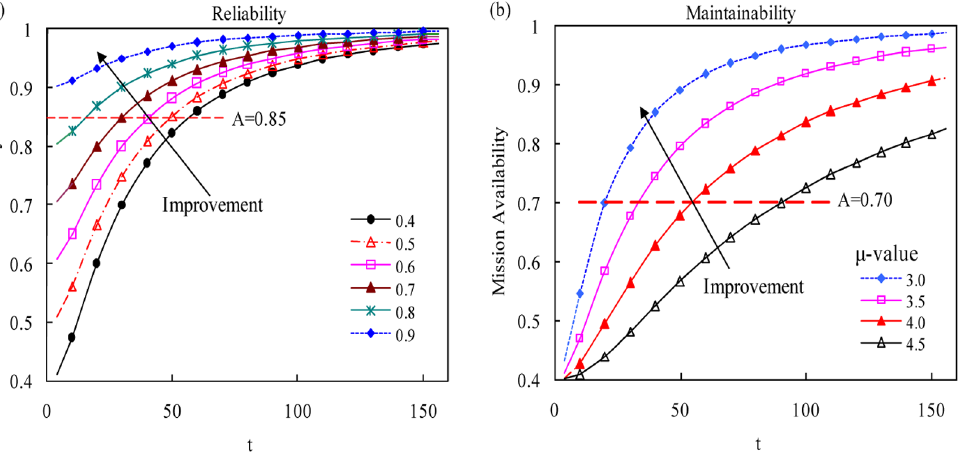
Figure 6. Mission availability trend under different reliability/Maintainability level. (a) Mission availability trend when the system reliability is 0.4(0.1)0.9 and the cumulative repair function is Lognormal distribution with m ~ 3 : 4 , s ~ 0 : 95 . (b) Mission availability trend when the system reliability is 0.4 and the cumulative repair function is Lognormal distribution with m ~ 3 : 0 0 : 5 ð Þ 4 : 5 , s ~ 1 : 0 . The abscissas of the nodes between the red dotted line and curves represent the least bounded cumulative downtime when the required mission availability is 0.85 in (a) and 0.70 in (b).